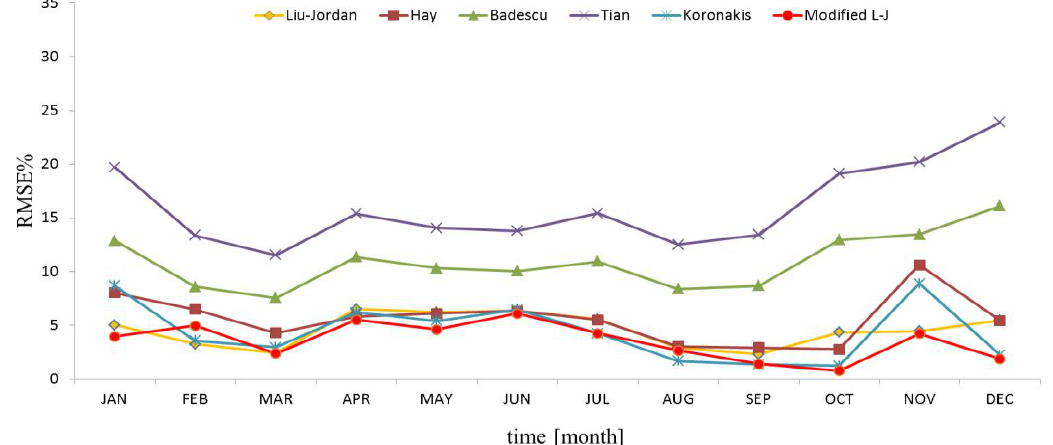
Figure 3. The differences in RMSE% of incident solar radiation of multiple models for a plane facing south at an inclination angle of 30° located in Poznań,